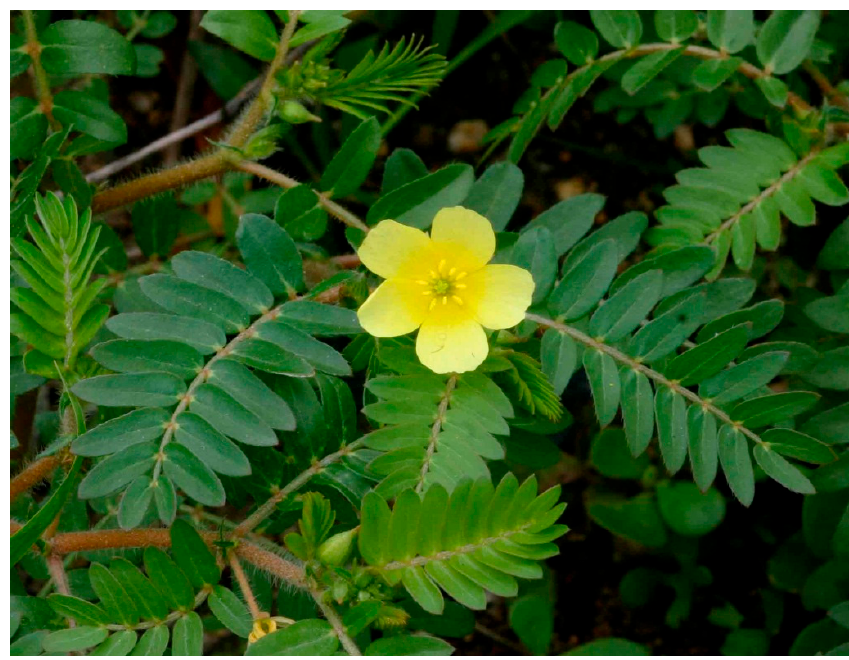
Figure 10. Image of Tribulus terrestris plant. Source: [119].